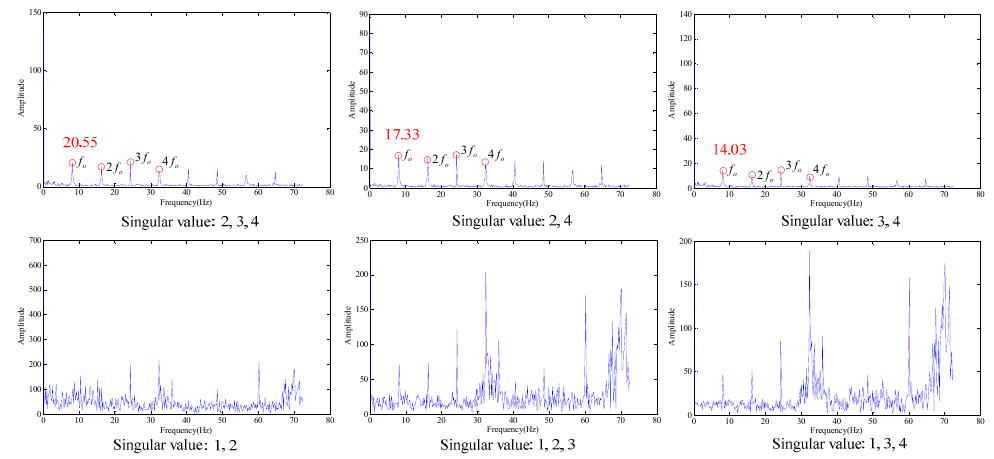
Figure 18. Filtering effective under different singular values.